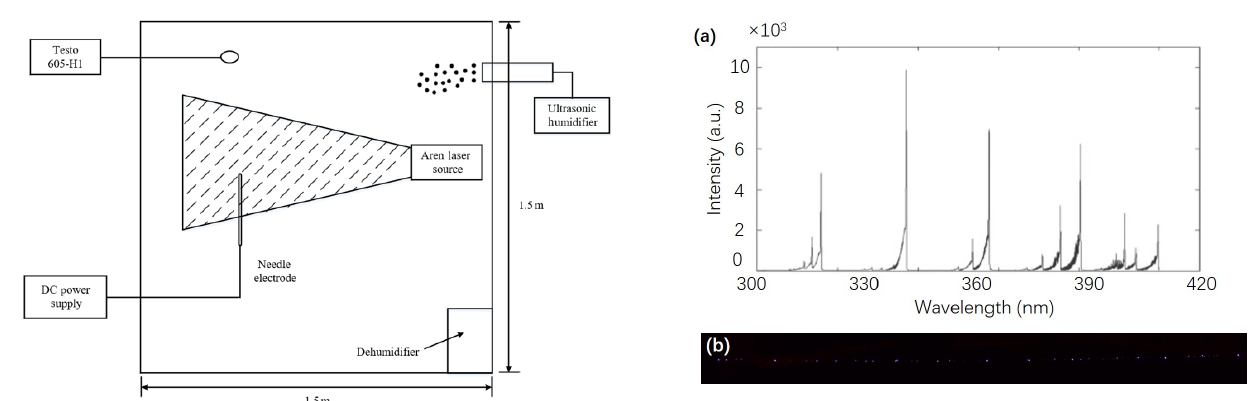
Figure 2. Schematic of the 6.75m 3 cloud chamber used for the ion- enhanced precipitation.